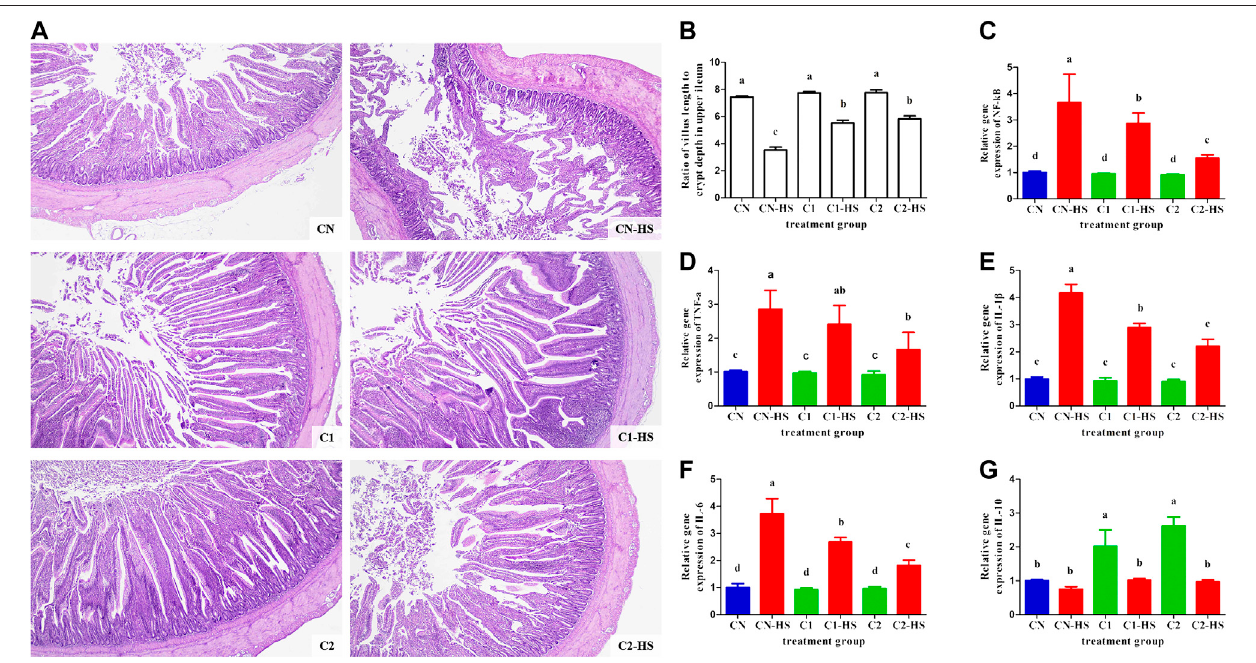
FIGURE 3 | Effect of 1,8-cineole microcapsule on pathological change and in fl ammation expression in upper ileum. Notes: (A) pathological changes in the upper ileum; (B) ratio of villus length to crypt depth; (C – G) the NF- қ B, TNF- α , IL-1 β , IL-6, and IL-10 gene expression. n (cid:2) 6.